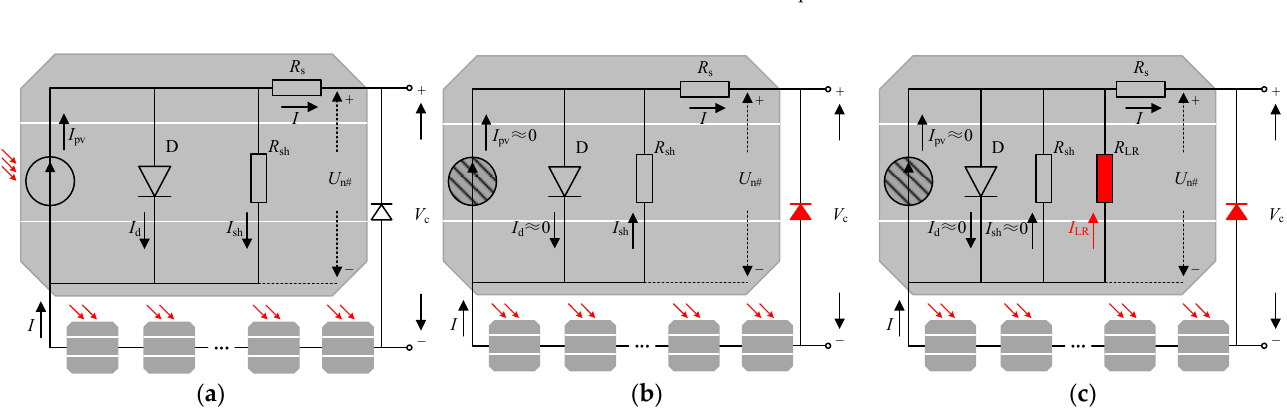
Figure 4. Schematic diagram of internal working state of photovoltaic unit: ( a ) normal unit (un- shaded); ( b ) normal unit (shaded); and ( c ) hot-spot unit (shaded).